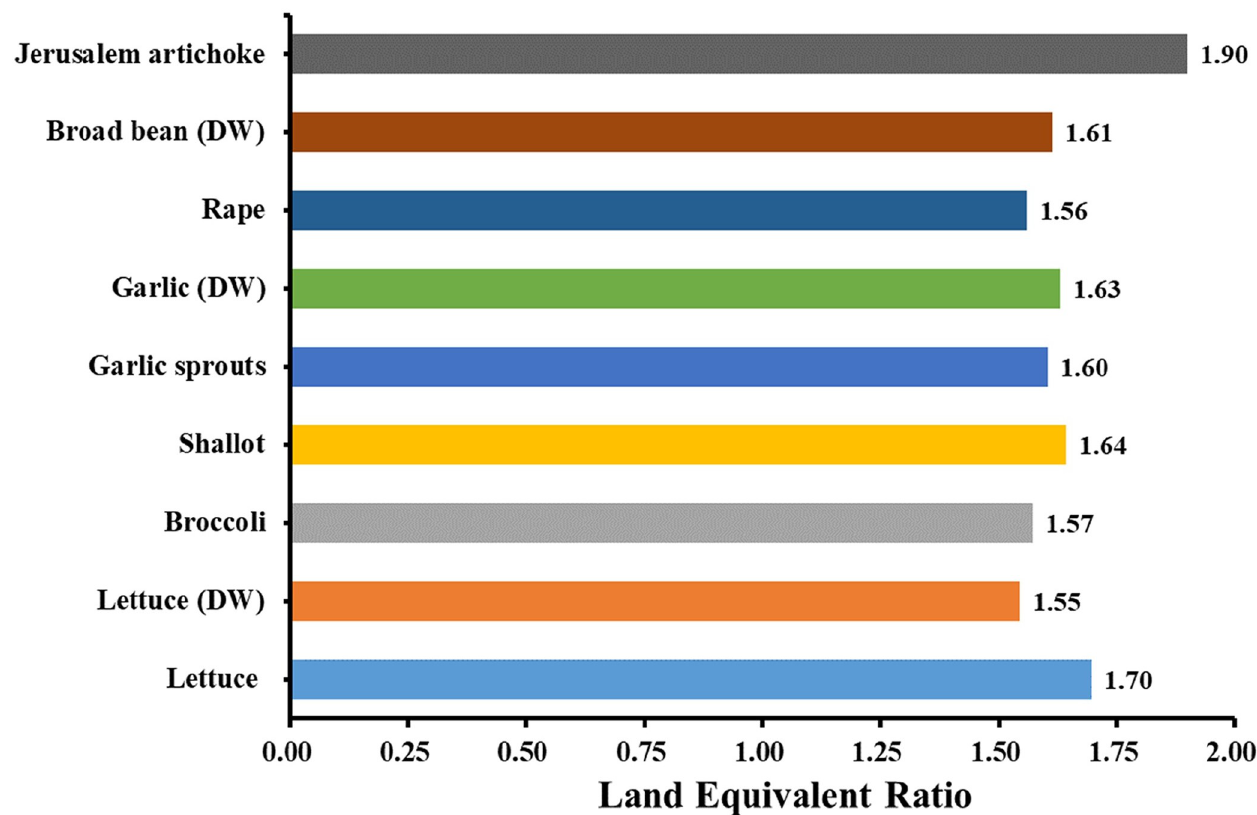
Fig 7. Land equivalent ratio of EAS for experimental plant varieties. DW: Dry weight.